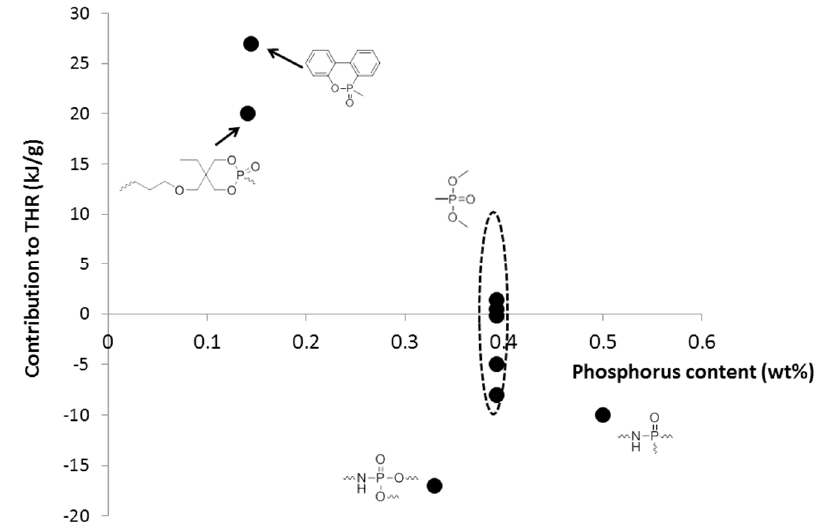
Figure 12. Contributions to THR for various phosphorus-containing groups according to different Figure12. ContributionstoTHRforvariousphosphorus-containinggroupsaccordingtodi ff works.